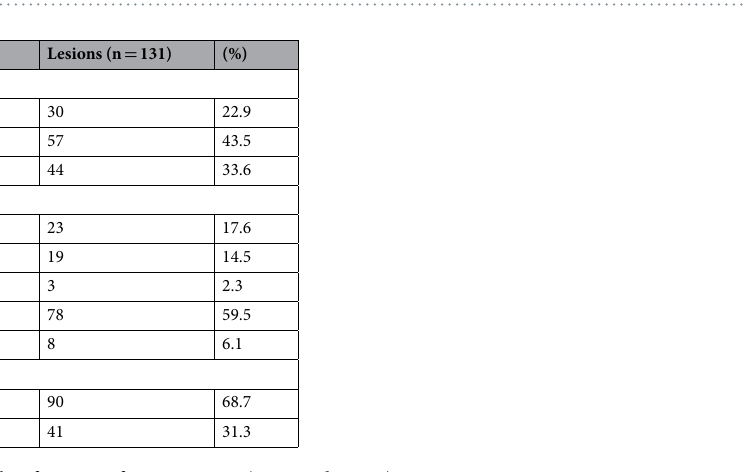
Table 5. Mammographic features of IHM masses (n = 131